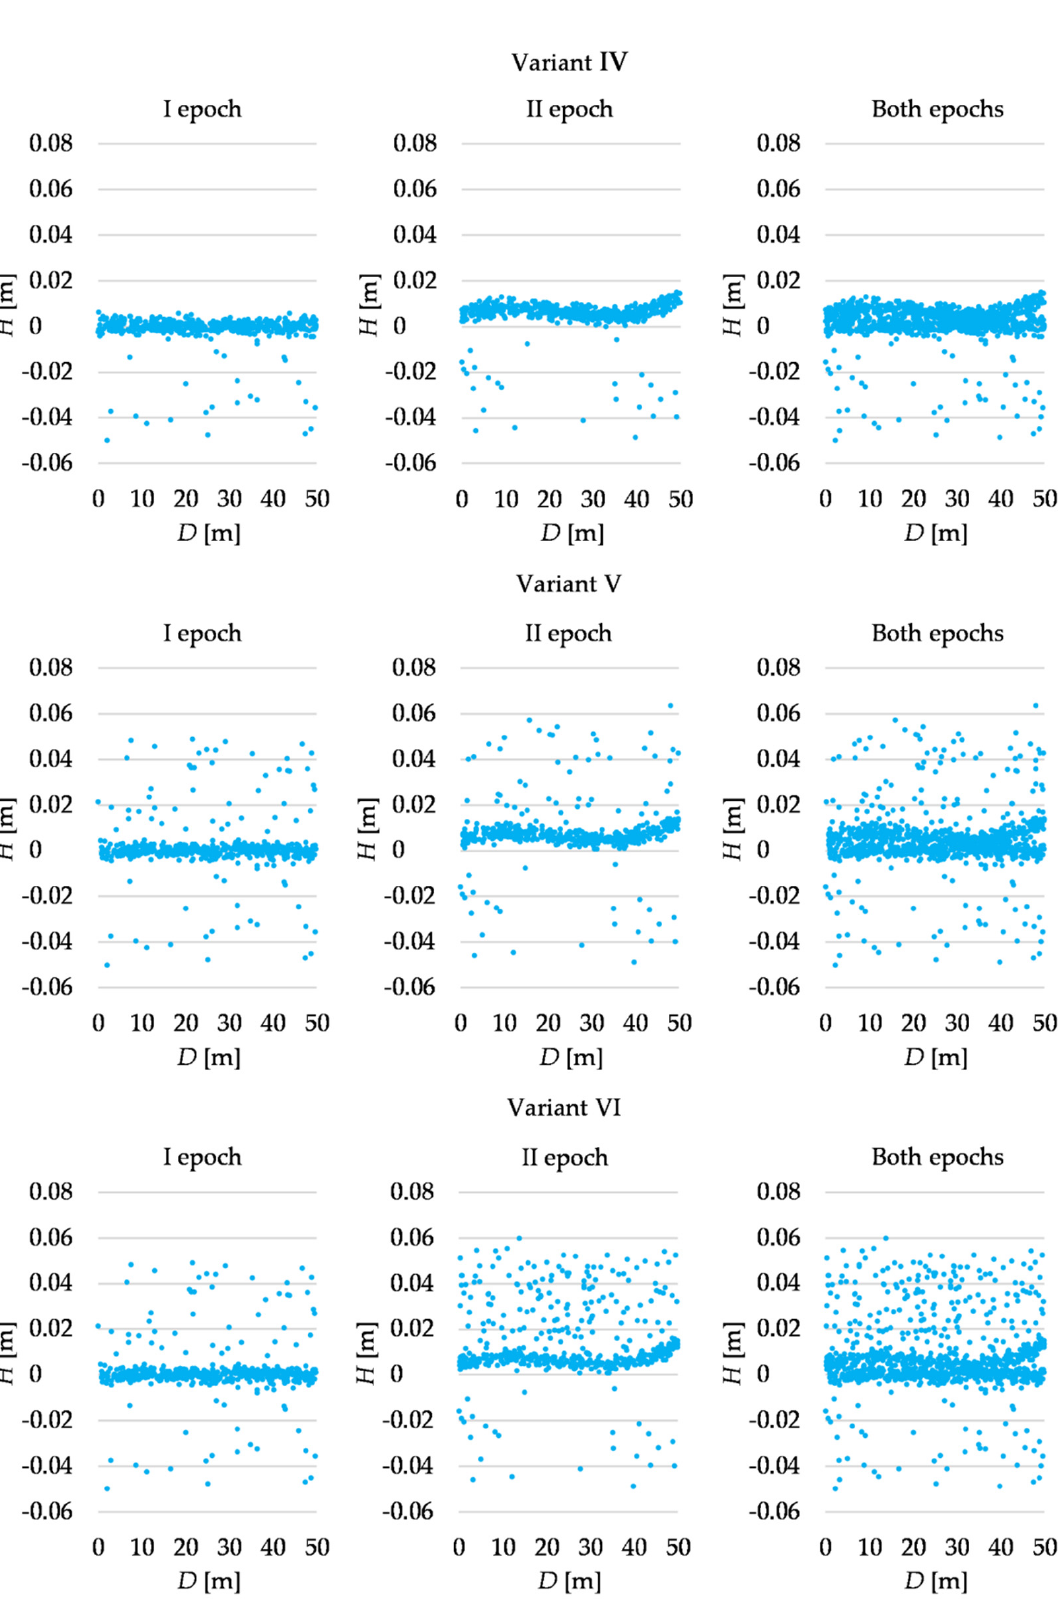
Figure 2. Observation sets for Variants IV–VI.